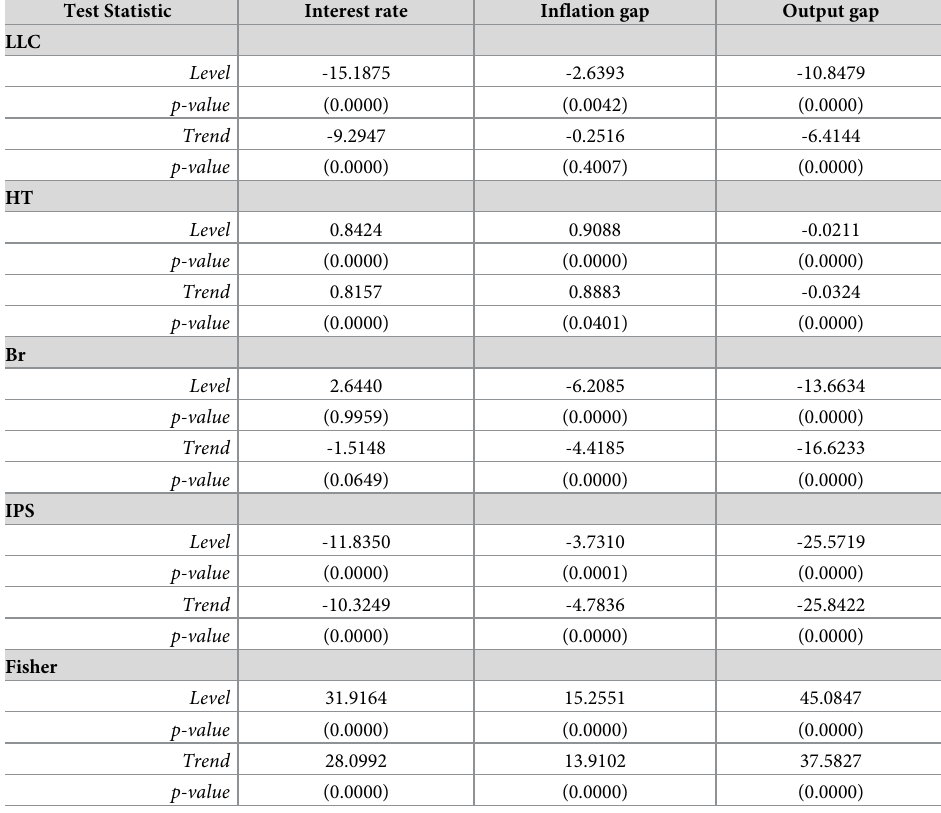
Table 1. Results of unit roots